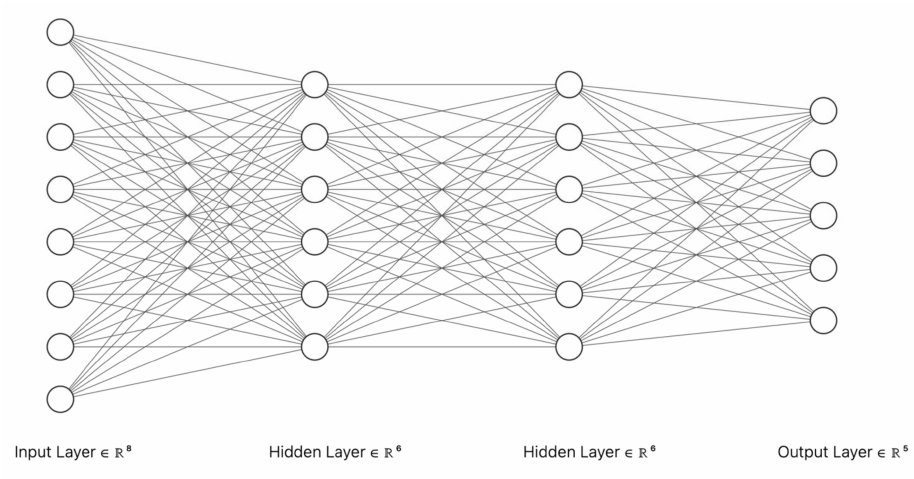
Figure 5. Architecture of the proposed neural